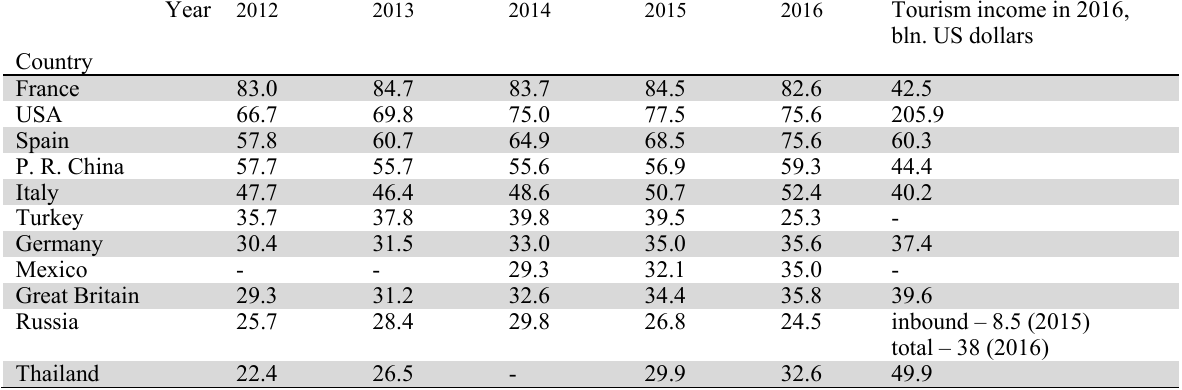
Annual number of foreign tourists in the world’s most visited countries, million people Year